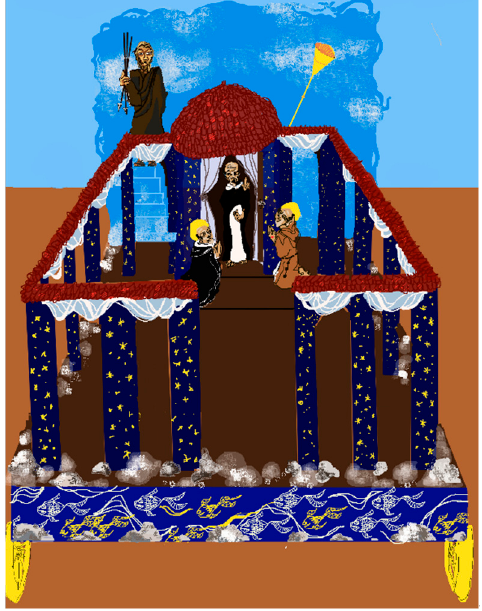
Figure 1. Author’s idealized reconstruction of “ L’entramès de mestre Vicent .”